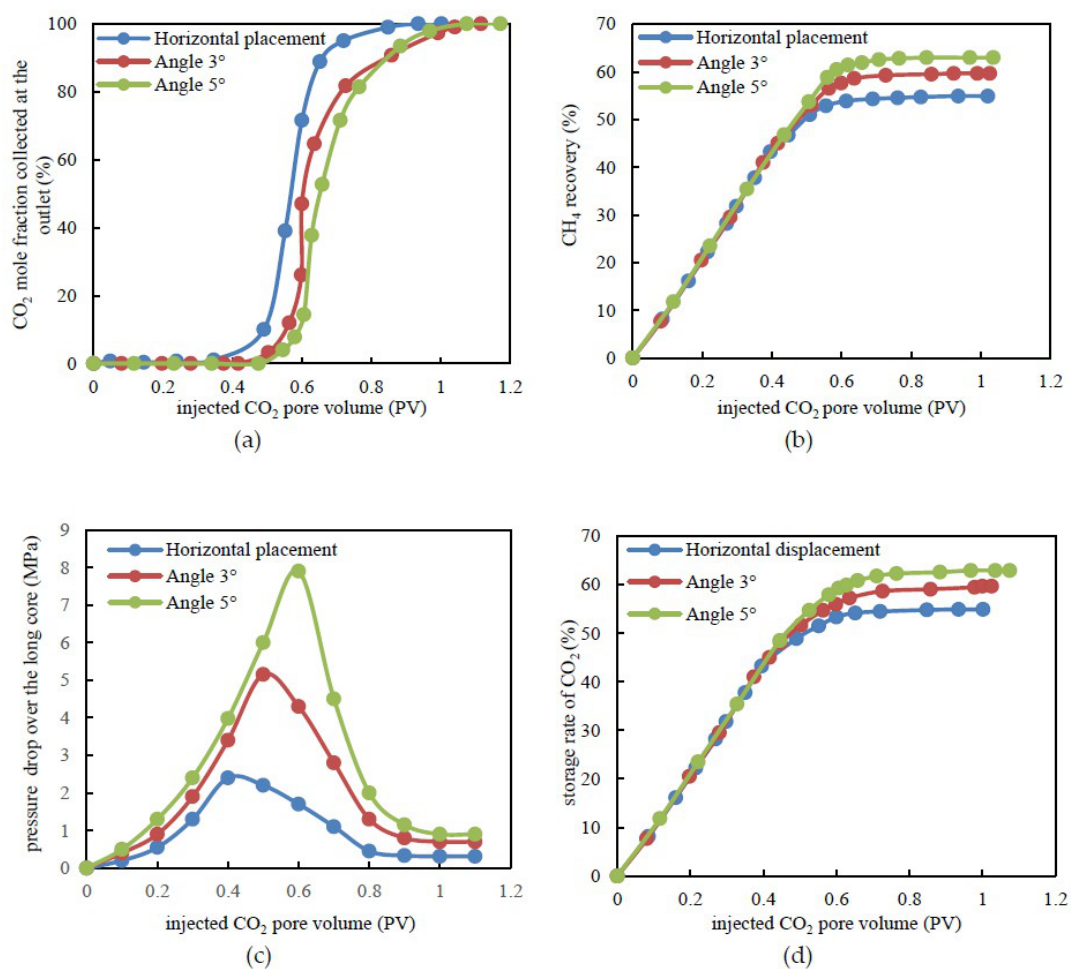
Figure 6. Experimental results under various formation dip angle conditions. ( a ) CO 2 mole fraction at the outlet versus injected CO 2 pore-volume. ( b ) CH 4 recovery by CO 2 flooding. ( c ) Pressure drop over tight long-core versus the pore-volume during CO 2 flooding. ( d ) The storage rate of CO 2 versus injected CO 2 pore-volume.